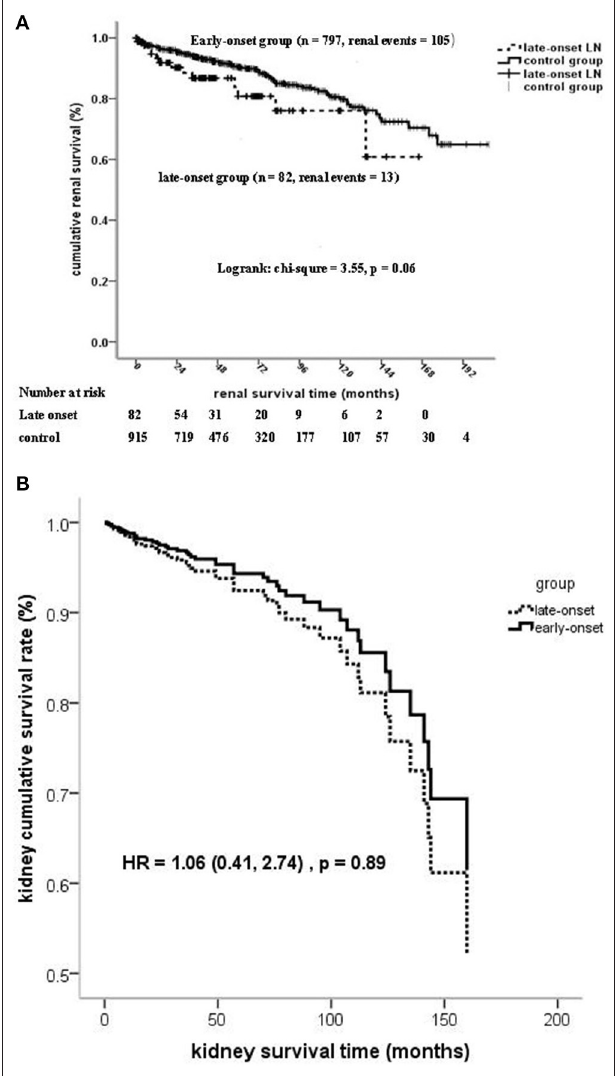
FIGURE 2 | (A) Kidney survival (at the composite endpoint of serum creatinine doubling and ESRD) stratified on the age of LN onset. (B) Kidney survival (at the composite endpoint of serum creatinine doubling and ESRD) stratified on the age of LN onset by cox regression.